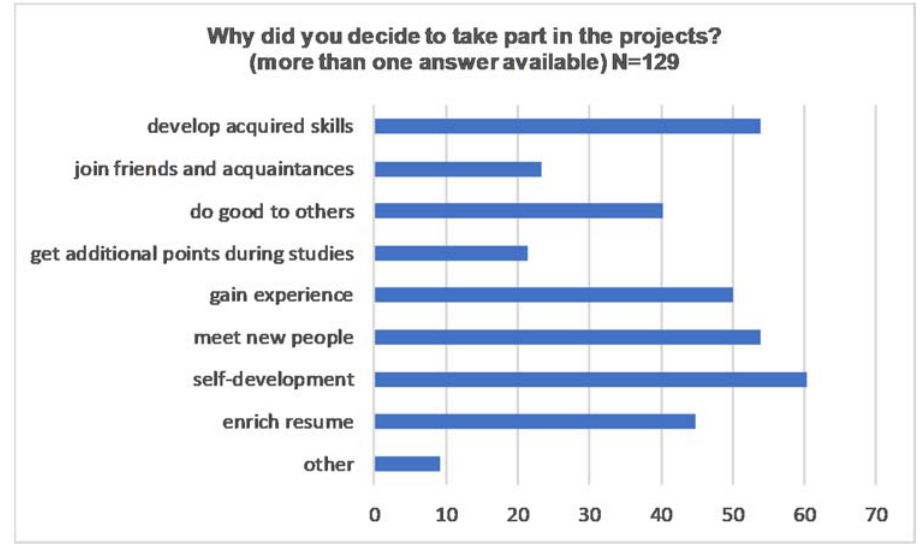
Figure 3. Motives for participating in extracurricular projects.